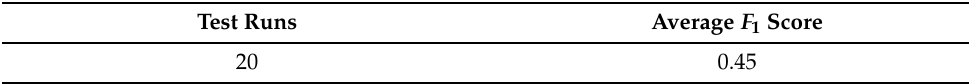
Table 9. BusyBox Similarity Using OpenSSL